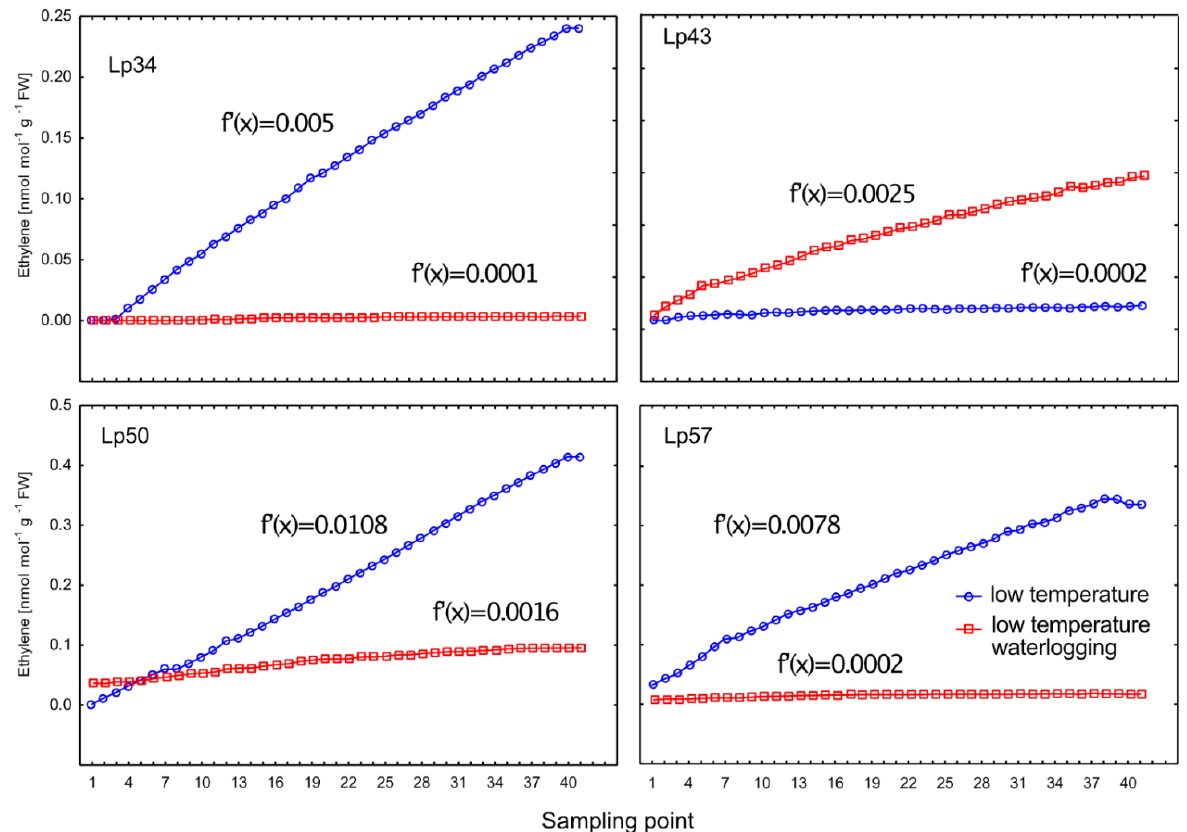
Figure 2. Ethylene accumulation in 2 dm 3 glass cuvettes after 3 weeks of cold acclimation in waterlogged and control plants of Lolium perenne . Measurements were recorded at 1 min 10 s intervals (41 sampling points) and flow rate of 250 cm 3 /min. Four genotypes (Lp34, Lp43, Lp50, and Lp57) were tested. Function derivatives [ f ′( x )], describing the ethylene rate of change, are presented.